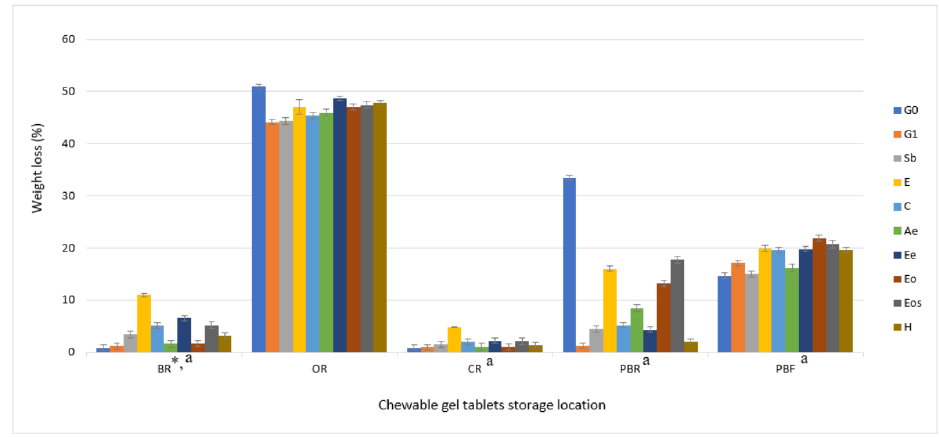
Figure 4. Dependence of changes in the mass of chewable gel tablets on storage conditions, n = 8. * the change in mass was calculated from the last results before appearance of mold; a— p < 0.05 vs. OR conditions.